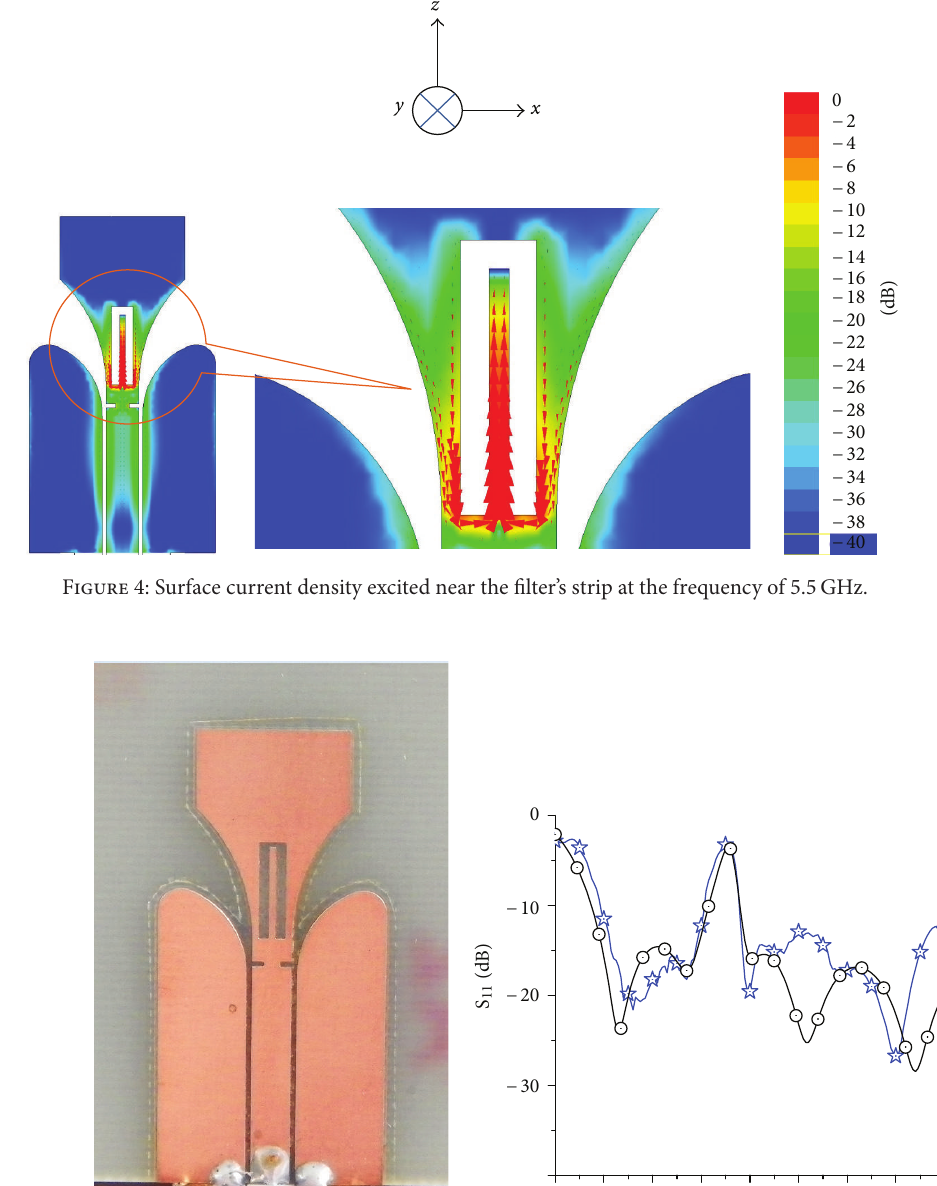
slot �lter. e measured radiation patterns in